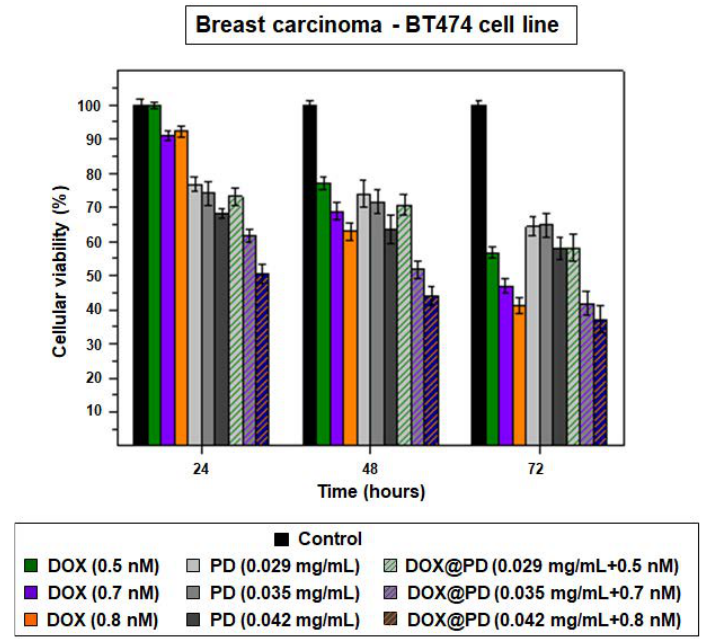
Figure 7. Results of the MTT assay carried out with the BT474 cell line, previously treated with free DOX (0.5 (green), 0.7 (purple) and 0.8 (orange) nM), 115 nm PD NPs (0.029, 0.035 and 0.042 mg / mL (grayscale)) and DOX@PD NPs (grayscale with colored patterns) in equivalent concentrations. The results shown are the mean ± SD of three replicates for each